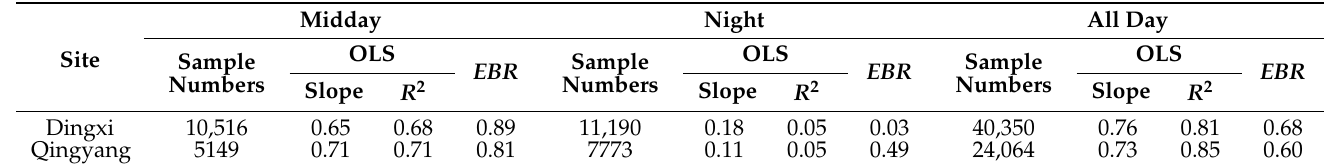
Table 2. Characteristics of the energy balance in different regions.